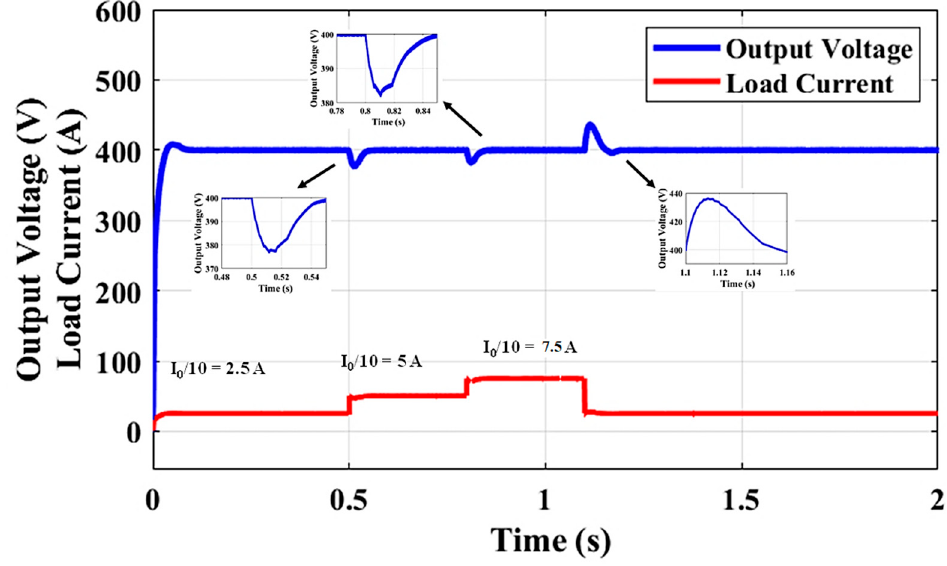
Figure 14. Output voltage response with step change in load resistance for proposed HG-SIQBC for V in = 75 V .